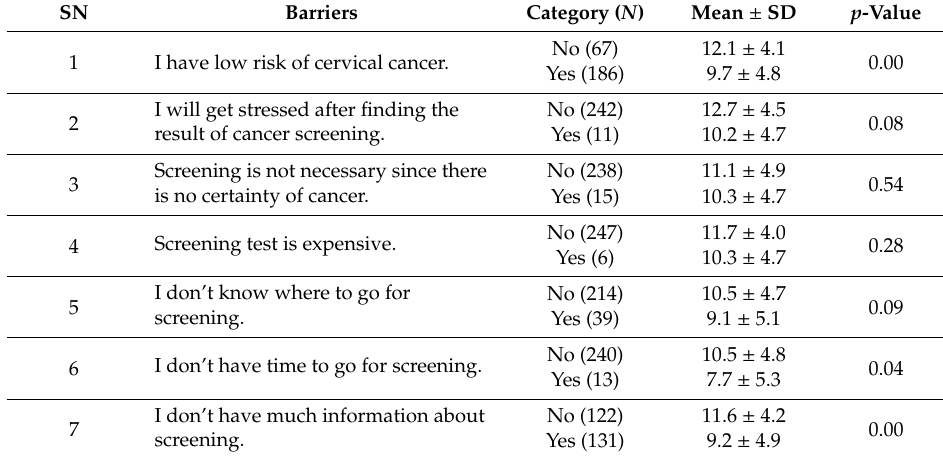
Table 5. Relationship between the total cervical cancer knowledge score and the barriers to screening perceived by mothers.